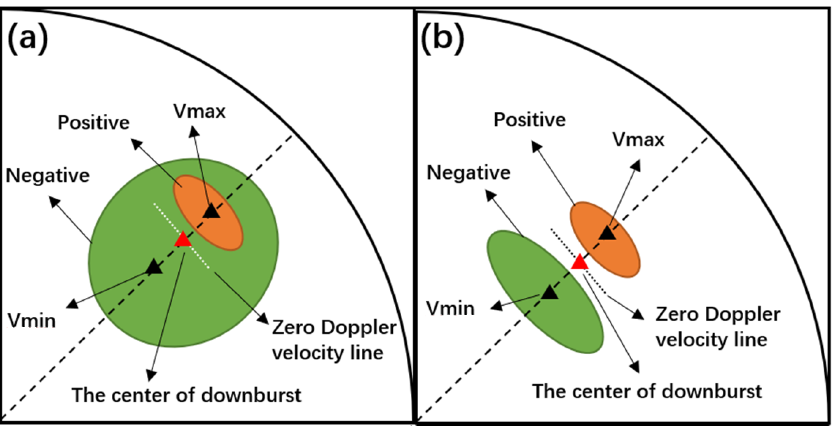
Figure 7 Figure 7. Schematic of identifying the center of the downburst area. ( a ) Schematic of the recognition center of large and small circles; ( b ) Schematic of the recognition center of two adjacent